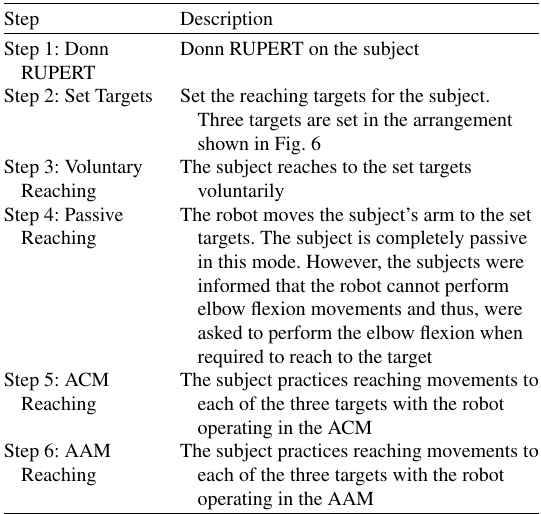
Table 3 Description of the protocol used for testing the RUPERT